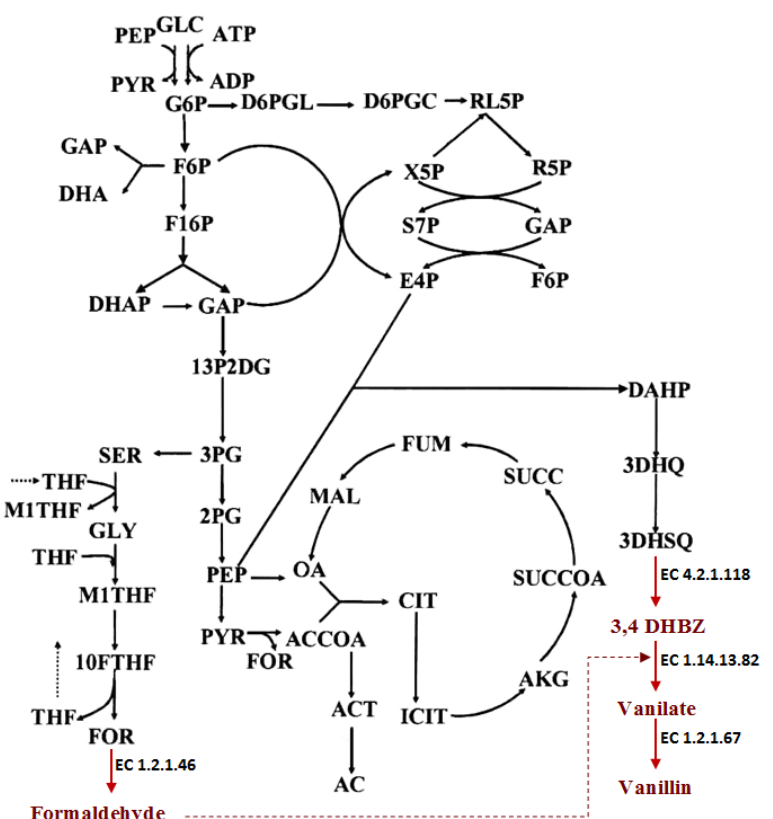
Figure 7: The added pathway for vanillin production. The figure is partially adapted from Maranas et al.